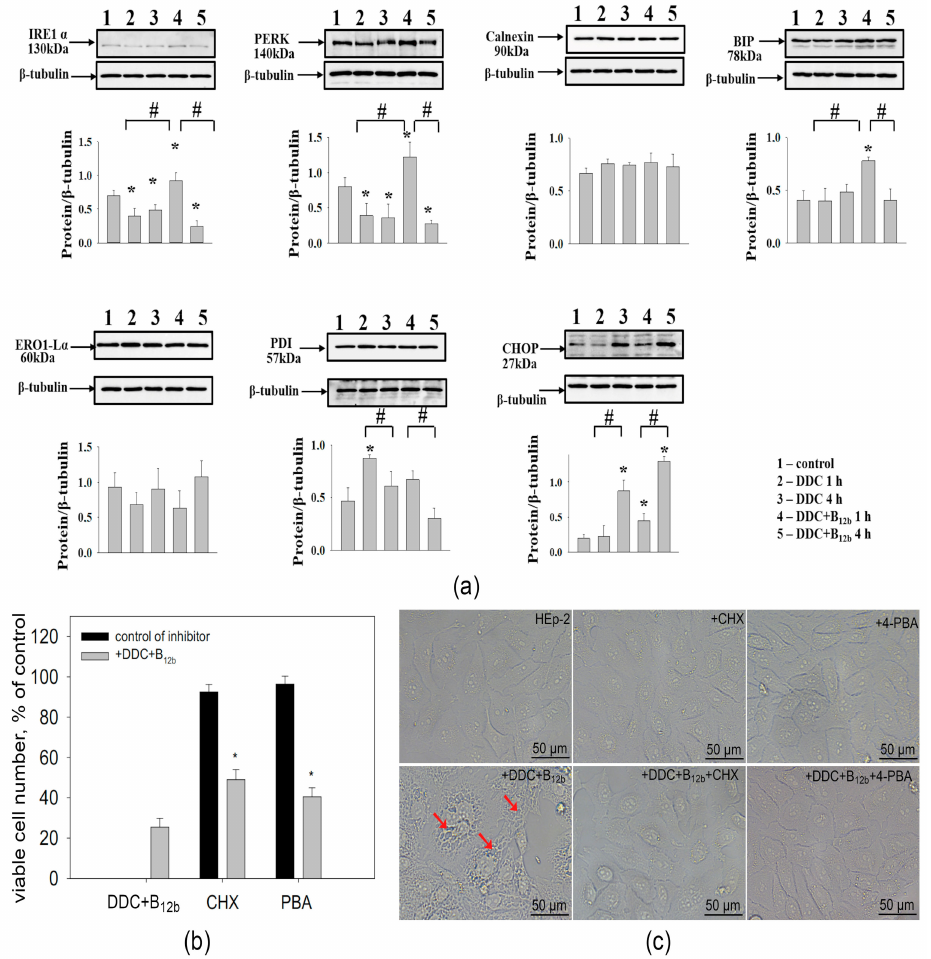
Figure 10. ER stress induced by the action of DDC + B 12b causes the disturbance of the synthesis and folding of the protein in HEp-2 cells. Immunoblot analysis of ER-stress markers in HEp-2 cells after 1-h and 4-h incubations with DDC (1 mM) or DDC (1 mM) + B 12b (25 µ M) ( a ). *, di ff erences are significant compared with control cells; #, significant di ff erences between the groups, p < 0.05. The e ff ect of protein synthesis inhibitors on the cytotoxicity of DDC + B 12b ( b ) and vacuolization ( c ). Cells were incubated in growth medium for 90 min with 4-PBA or CHX, then DDC + B 12b was added, and after 5-h incubation, medium was replaced by a fresh growth medium without additives. The vacuolization was estimated immediately (bright field), and the cytotoxic e ff ect was estimated 48 h after the treatment. *, di ff erences are significant compared to cells incubated without the inhibitors, p < 0.05. The arrows point to vacuoles in cells treated with DDC + B 12b